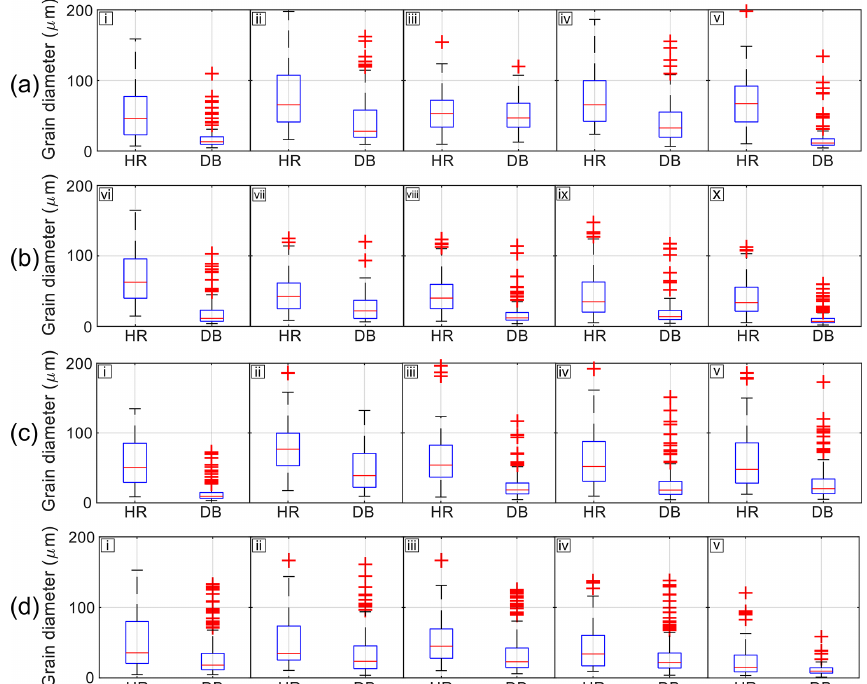
Figure 9. Box-and-whisker plots to show the difference in grain size distribution in deformation bands compared with host rock. (a) Grain size distributions associated with deformation bands located in D2 fault damage zones. (b) Grain size distributions associated with deformation bands located in D3 fault damage zones. (c) Grain size distributions associated with D3 non-FDZ deformation bands. For each sample, the interquartile range and the median are smaller in the deformation bands compared with the host rock. The tops and bottoms of each box are the 25th ( Q 1 ) and 75th ( Q 3 ) samples respectively. The centre line represents the median. The whiskers are drawn from the ends of the interquartile ranges to the adjacent values ( Q 1 − 1.5 · interquartile range, and Q 3 + 1.5 · interquartile range). Data that lie beyond the whisker length are outliers (red